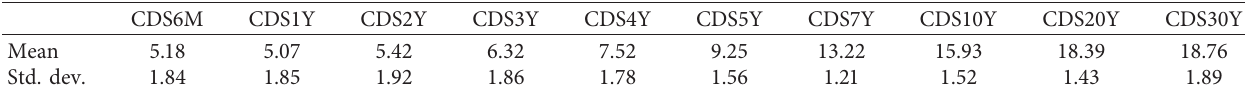
Table 4: Summary statistics for test dataset 1 for the full period and subperiod 2 training sets.